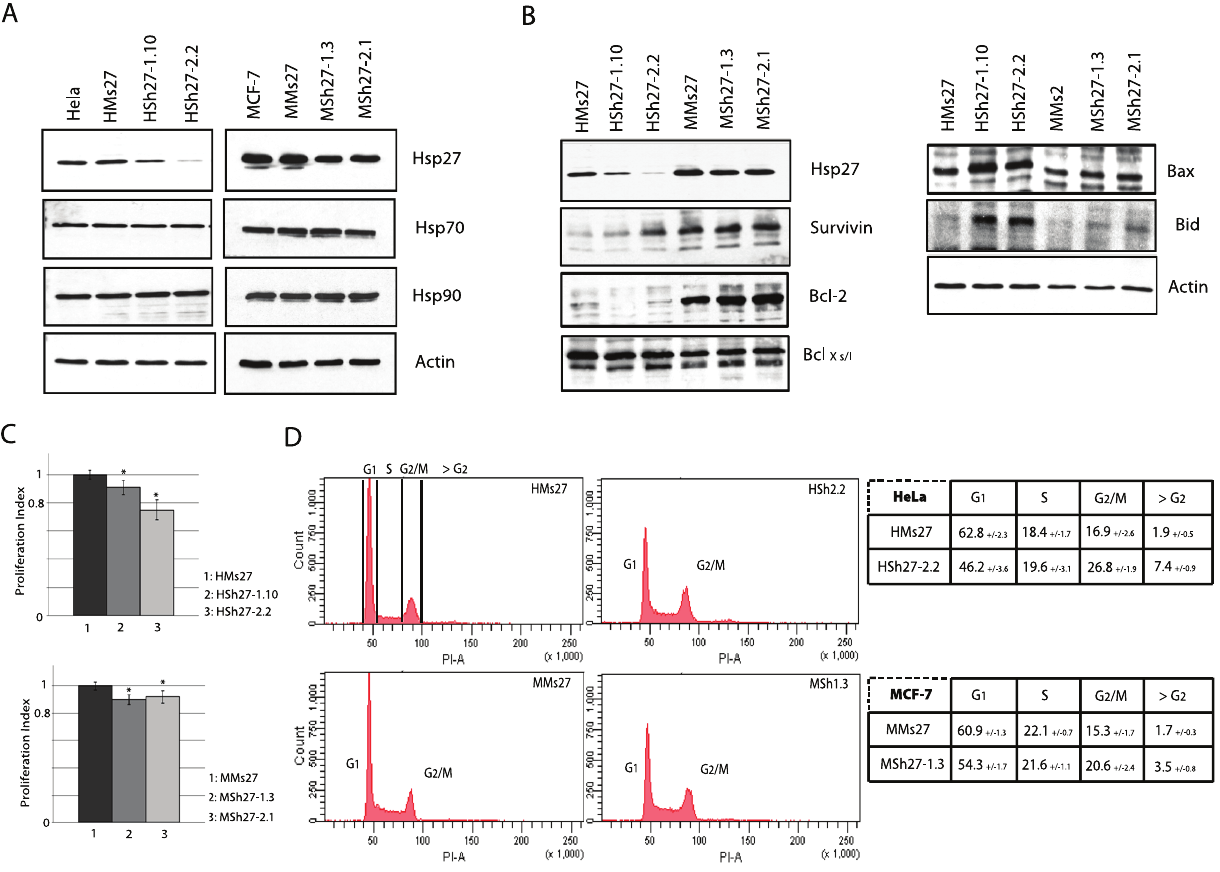
Figure 2. Hsp27 knock down clones, enriched in G2/M cells, show decreased cell proliferation. Constitutive Hsp27 depleted clones of HeLa or MCF-7 were isolated as described in Materials and methods. A , HeLa or MCF-7 samples from independent Hsp27 depleted clones were collected and levels of Hsp27, 70 and 90 were analyzed by western blot. B , Immunoblot analysis of Hsp27, survivin, Bcl-2, Bcl Xs/l , Bax, Bid and actin present in both HeLa and MCF-7 depleted clones. C , WST-1 test was performed each 12 h during five days. Proliferation index was determined and reported for each cell line ( p , 0.01). D , Cell cycle study was performed by flow cytometry analysis after PI staining as previously described [26]. Quantifications experiments were realized and reported in tables presented on the left of the flow cytometry